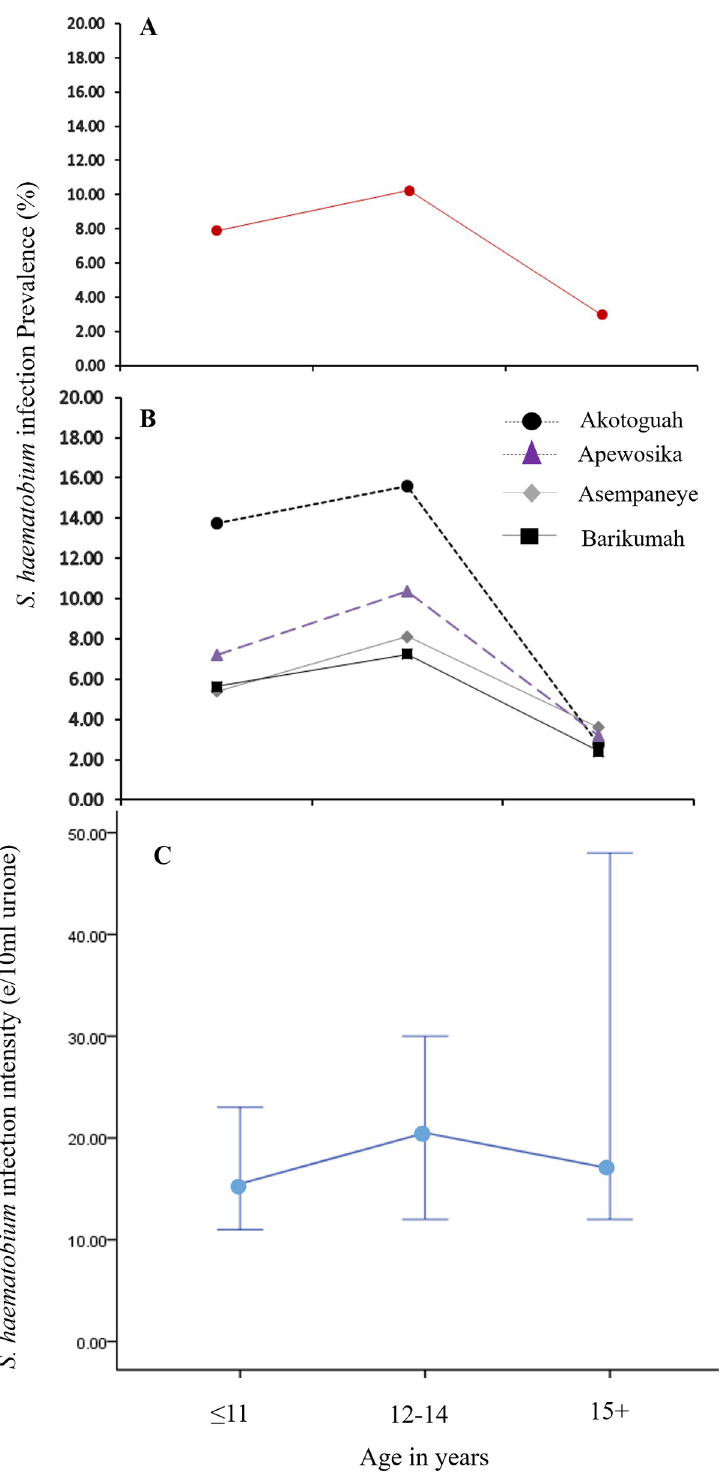
Fig 2. (A) Overall percent S . haematobium infection prevalence distribution by age groups (B) Percent S. haematobium infection prevalence distribution by age groups for the four study communities. (C) The overall S . haematobium infection intensity distribution by age